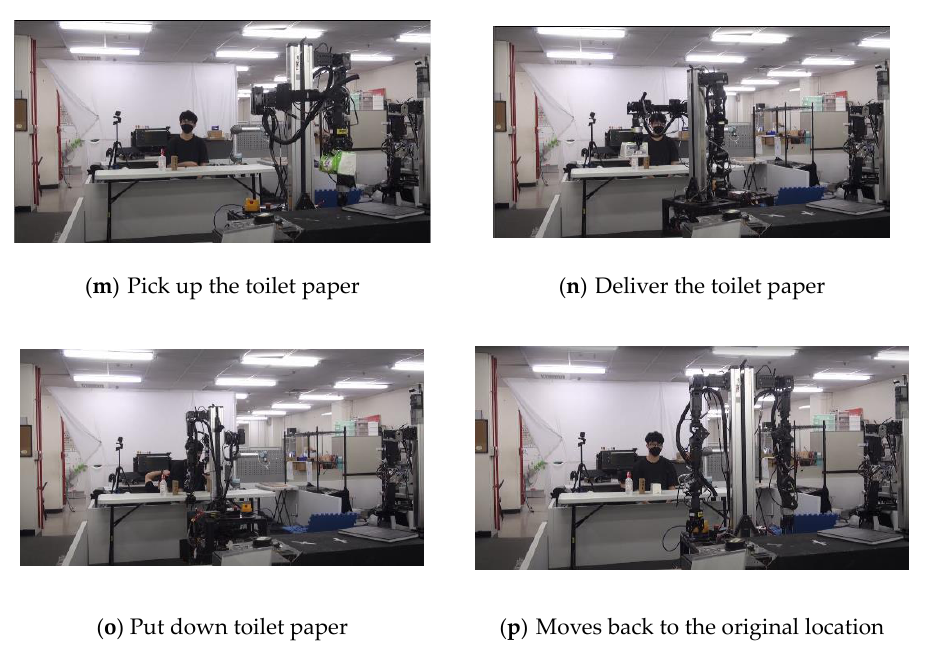
Figure 18. Sequential actions of a real mobile robot for different service tasks.